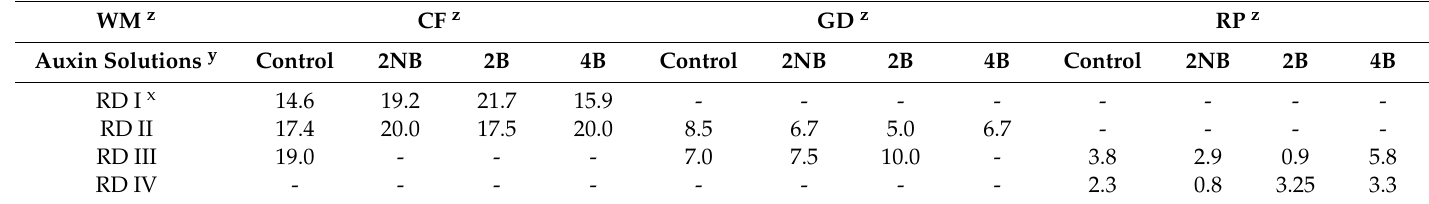
Table 3. The root numbers of wounding method (WM), root diameter (RD), and auxin solution treatment combinations on the F. elastica heritage tree.